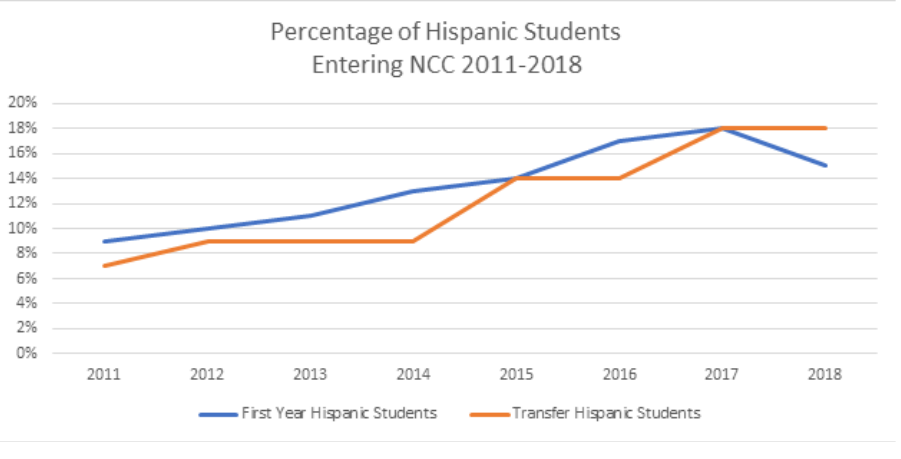
Table 1: Percentage of Hispanic Students entering NCC